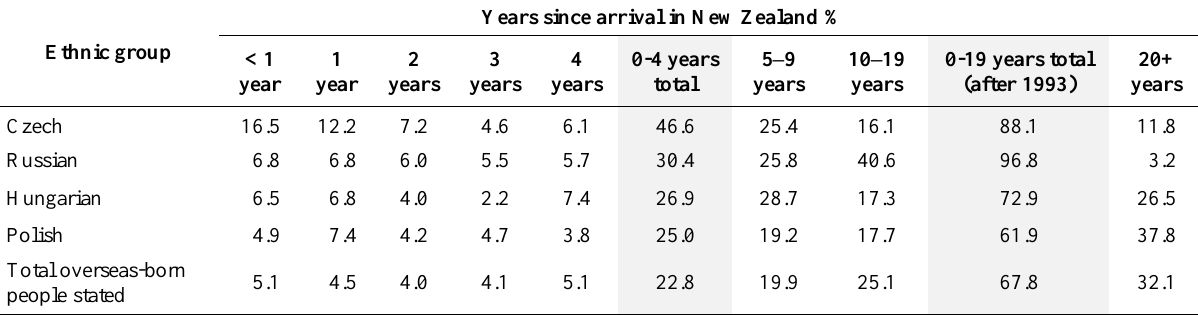
Table 8. Ethnic groups (detailed total responses) by years since arrival in New Zealand, overseas-born usually resident population count, 2013 census Years since arrival in New Zealand % Ethnic group <